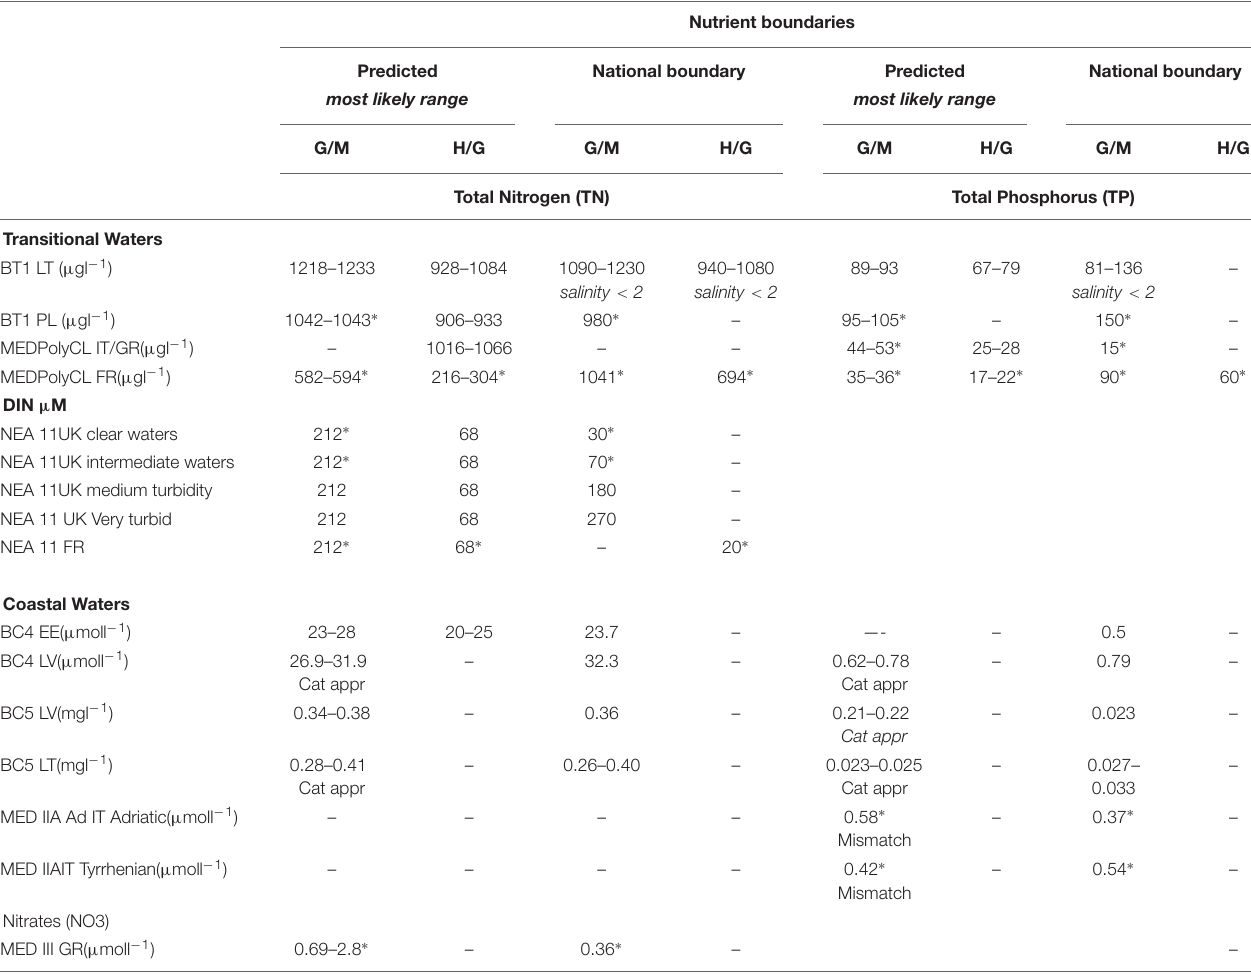
TABLE 5 | Comparison of range of nutrient boundary values for TN and TP, obtained with linear regression and/or categorical approaches, with the range of national good/moderate and high/good boundary values for some transitional (TRW) and coastal (CW) waters common IC types across Europe (where data are available). Nutrient boundaries Predicted National